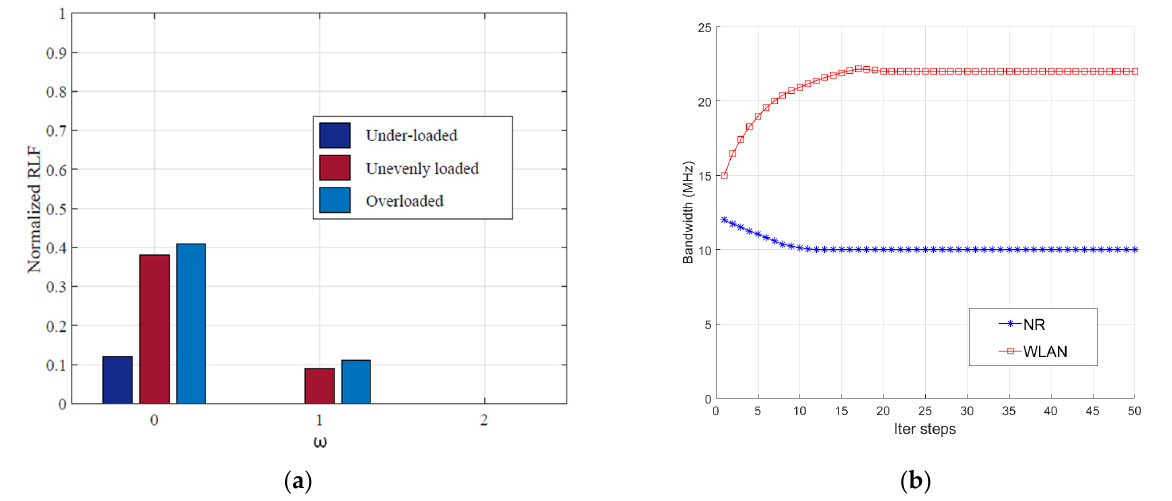
Figure 6. ( a ) Normalized RLF for under-loaded, unevenly loaded, and over-loaded scenarios for